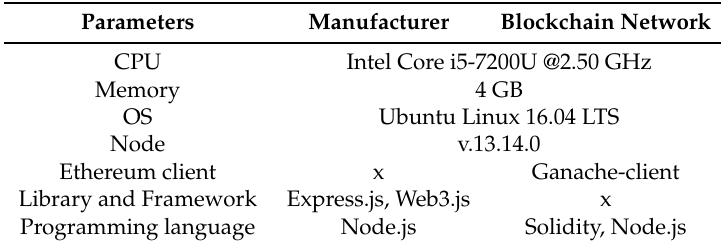
Table 2. Development environment for the manufacturer and the blockchain network.